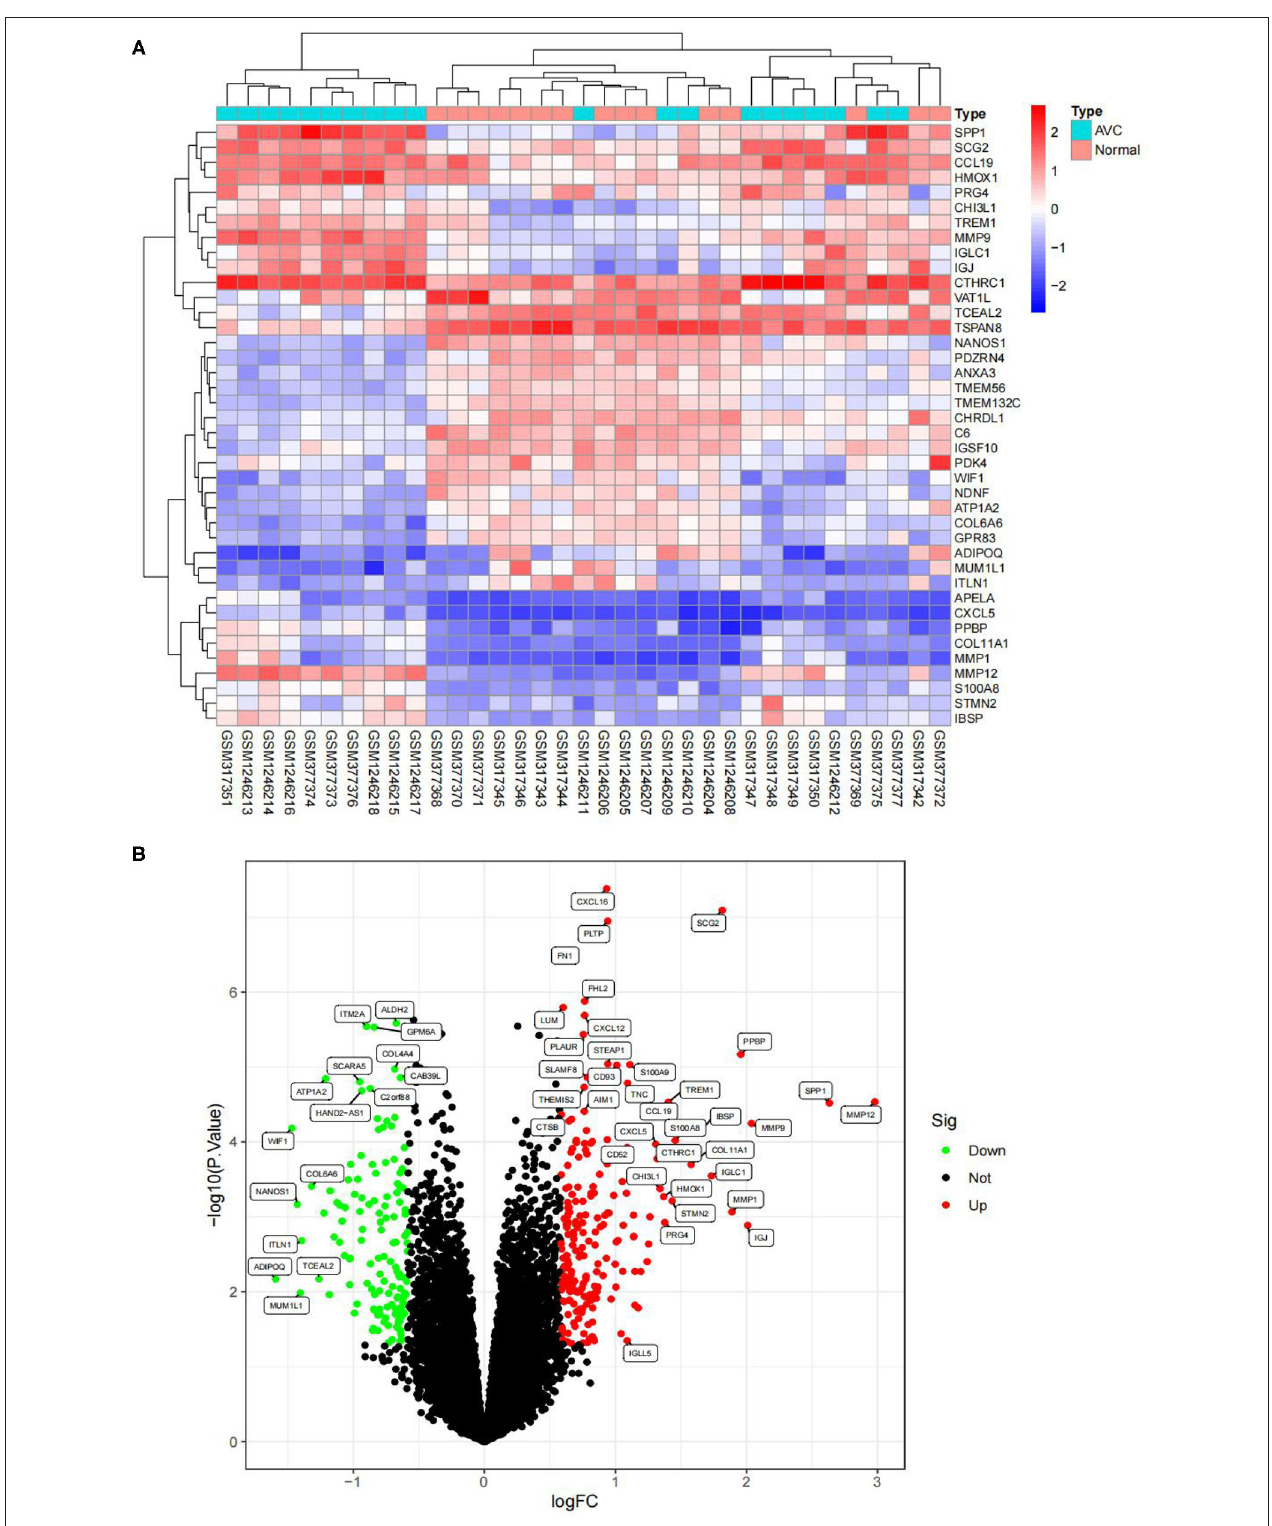
FIGURE 2 | Visualizing the results of differential genes. (A) Clustering heatmap of the genes exhibiting significantly differential expression AVC vs. normal group. Statistically significant DEGs were defined as |log2Foldchange| > 0.585 and P -value < 0.05. DEG, differentially expressed gene; AVC, Aortic valve calcification group. Cyan represents AVC groups; red-orange represents normal groups. (B) Volcano map of DEGs; red represents up-regulated differential genes, black represents no significant difference genes, and green represents down-regulated differential genes.